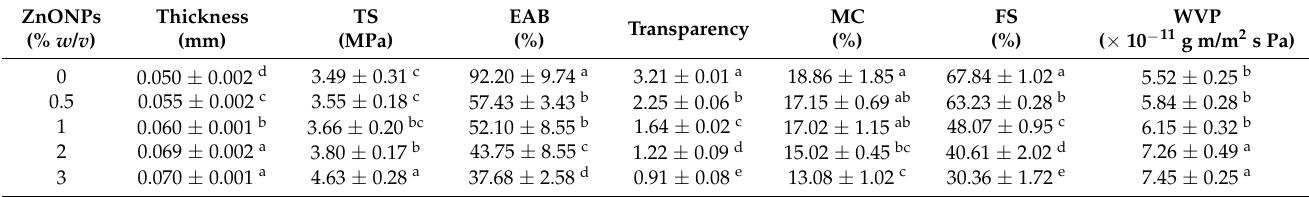
Table 1. Physicochemical, mechanical, and barrier properties of RS–G films reinforced with different concentrations of